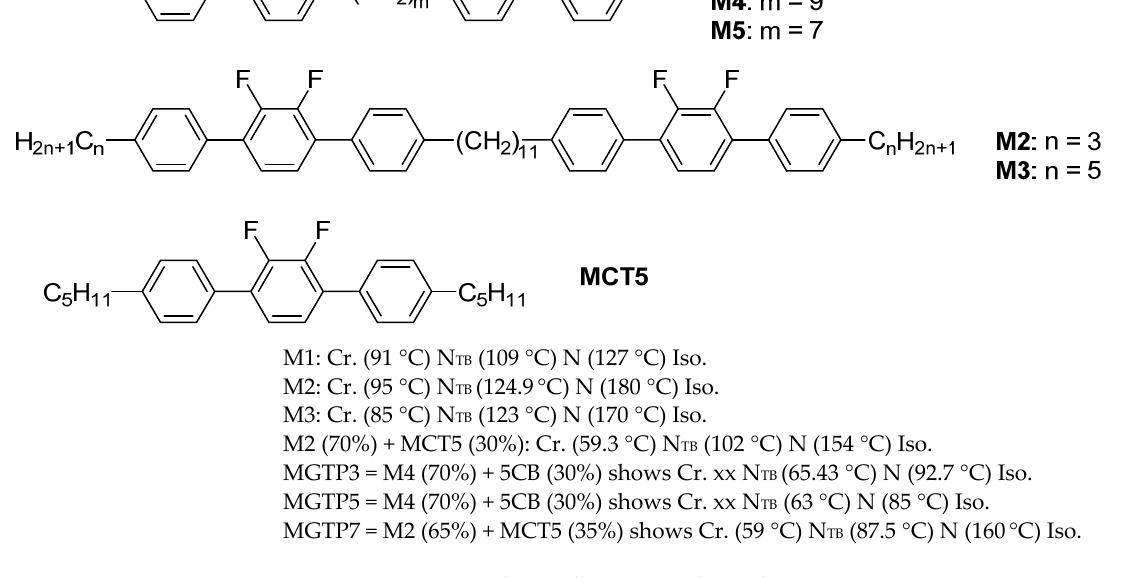
Figure 2. Liquid crystalline materials used.